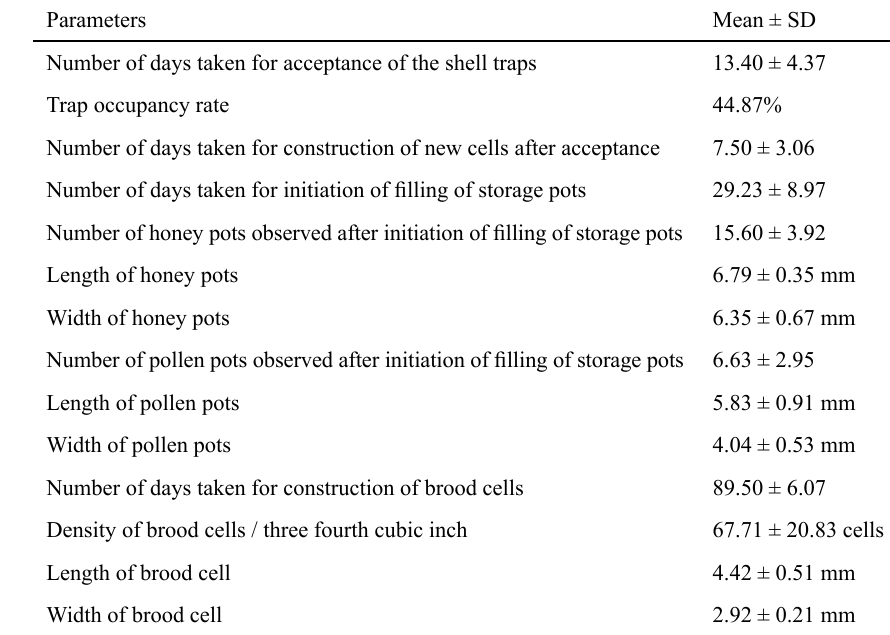
Table 1 . Colony development parameters of Tetragonula iridipennis in shell traps.